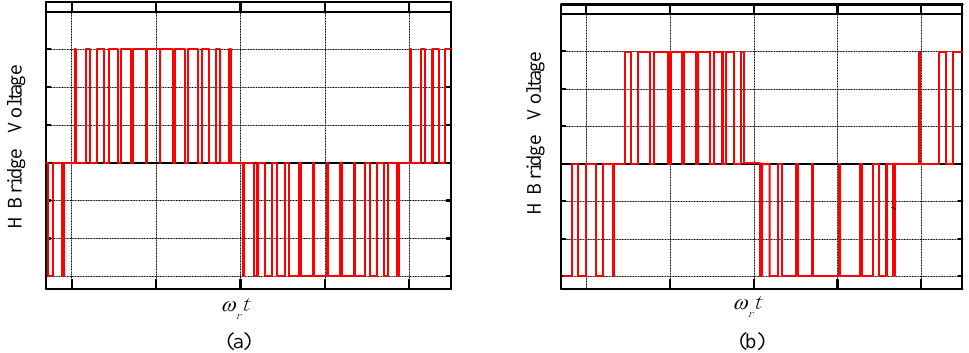
Figure 13. The output voltage of the power cell under continuous modulation and discontinuous modulation. ( a ) Output voltage under continuous modulation. ( b ) Output voltage under discontinuous modulation.